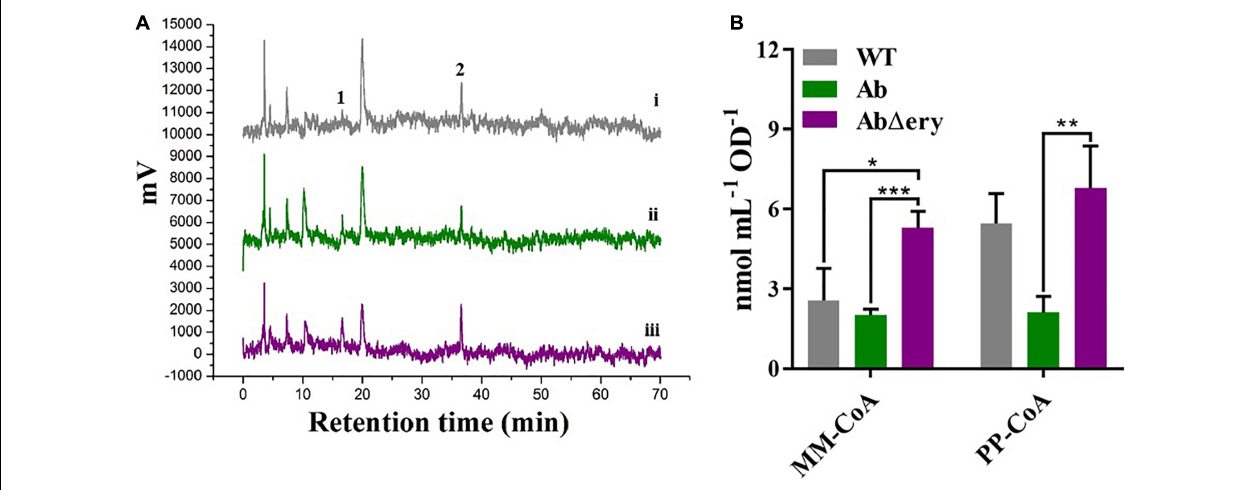
FIGURE 4 | Determination of CoAs concentration by HPLC. (A) HPLC analysis of intracellular coenzyme A in WT (i), Ab (ii), and Ab (cid:49) ery (iii). The peak 1 is MM-CoA (methylmalonyl-CoA) which peak time in spectrum is 17.6 min, and 2 is PP-CoA (propionyl-CoA) which peak time is 35.9 min. (B) Comparison of peak area of MM-CoA and PP-CoA between Ab (cid:49) ery (purple), Ab (green), and WT (gray).